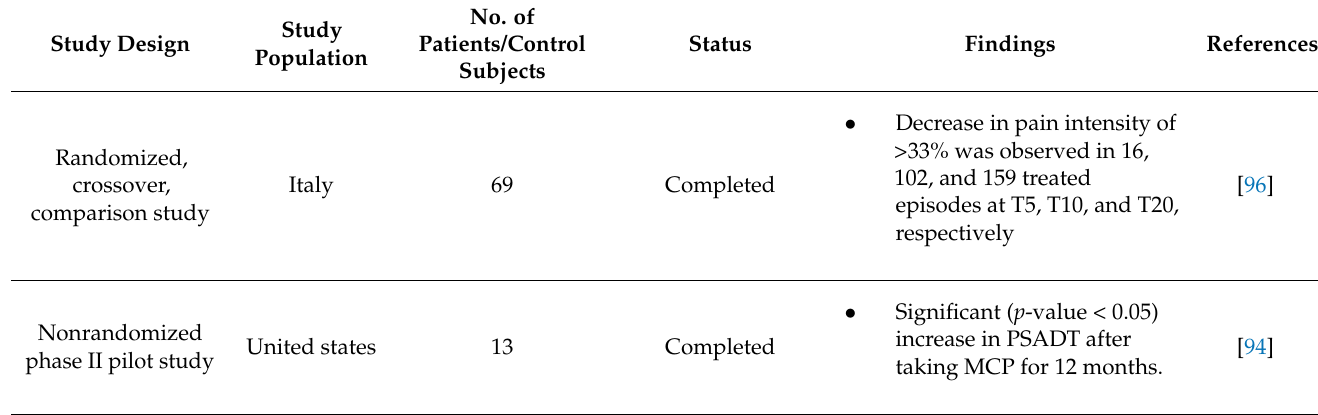
Table 2. Clinical evidences on the use of pectin and modified pectins in